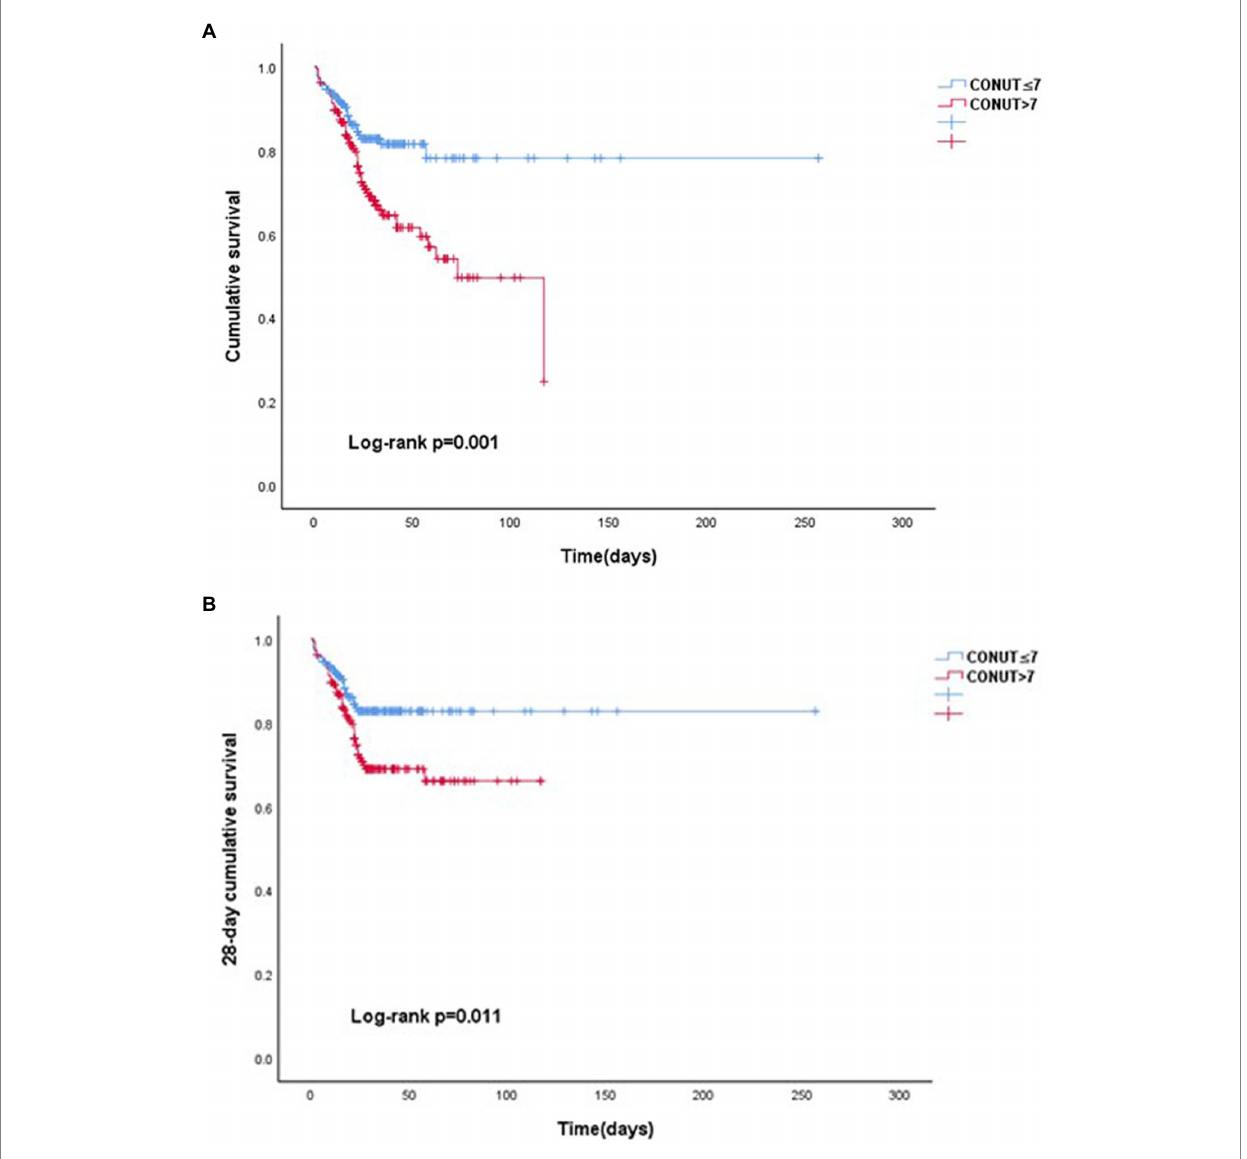
FIGURE 2 Kaplan–Meier curves for outcomes in patients with severe acute pancreatitis. (A) . All-cause mortality and (B) . 28 day